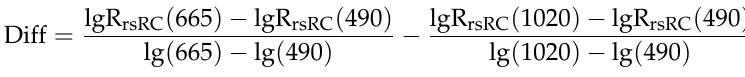
Figure 12. The results of the T index in Lake Erhai, Lake Dianchi, Lake Poyang, Lake Hongze, Lake Qinghai, Lake Fuxian, Lake Xingyun, Lake Yangzonghai, Lake Gehu, and Lake Taihu. Pixels of T ≥ 0 and T < 0 were sliced in rainbow and moccasin colors, respectively, and overlaid on the OLCI false-color image (R: OL17-865 nm, G: OL05-510 nm, B: OL02-412.5 nm).